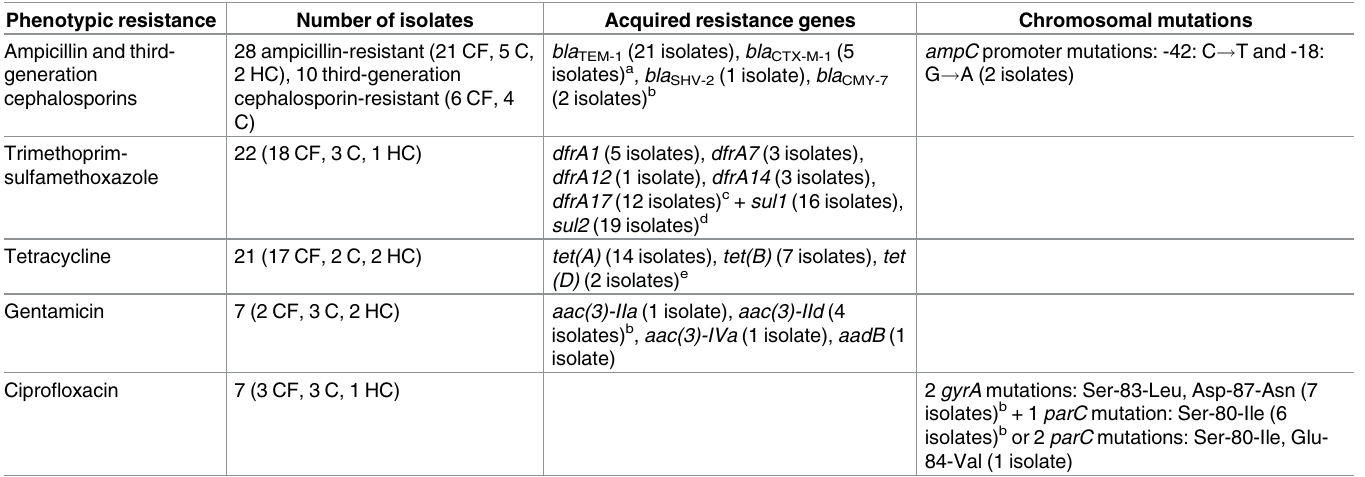
Table 6. Genotypic resistance mechanisms identified in 28 resistant Escherichia coli isolates from faecal samples from children with cystic fibro- sis (21 isolates), cancer (5 isolates) and healthy children (2